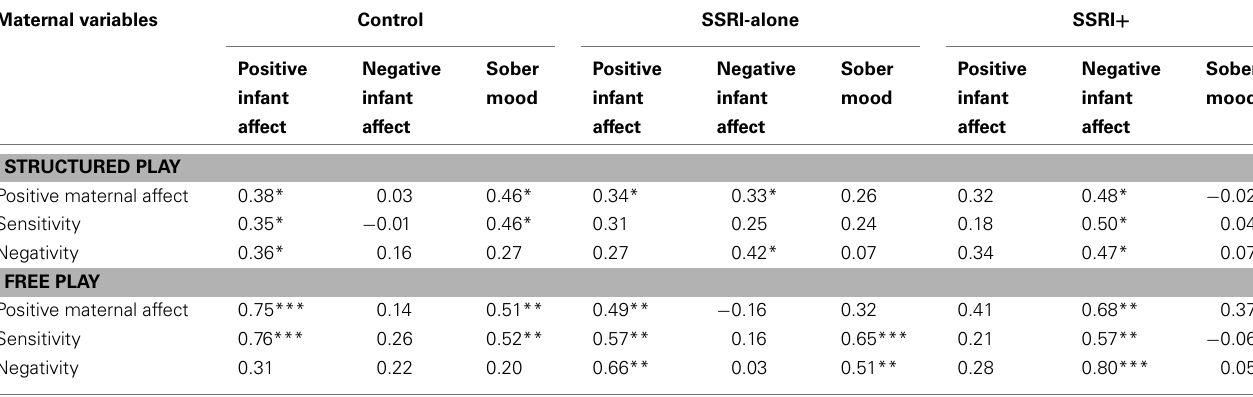
Table 5 | Intercorrelations (Kendall’s tau b) between maternal variables and infant variables for the three groups during structured play and free play at 8months.